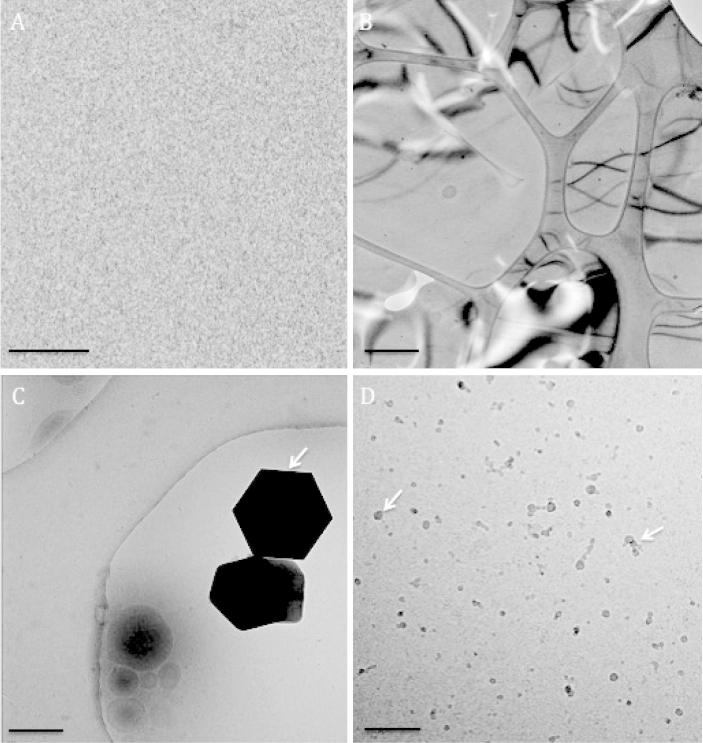
Examples of vitreous and non-vitreous ice. A) Empty, vitreous ice (Scale bar 50 nm). B) Hexagonal ice (scale bar 400 nm). C) Large ice crystal (white arrow) (scale bar 400 nm). D) Probable ethane contamination (scale bar 200 nm).